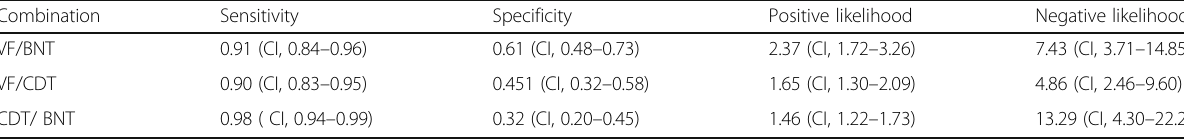
Table 4 Validity of different combinations of neuropsychological test for all participants Combination